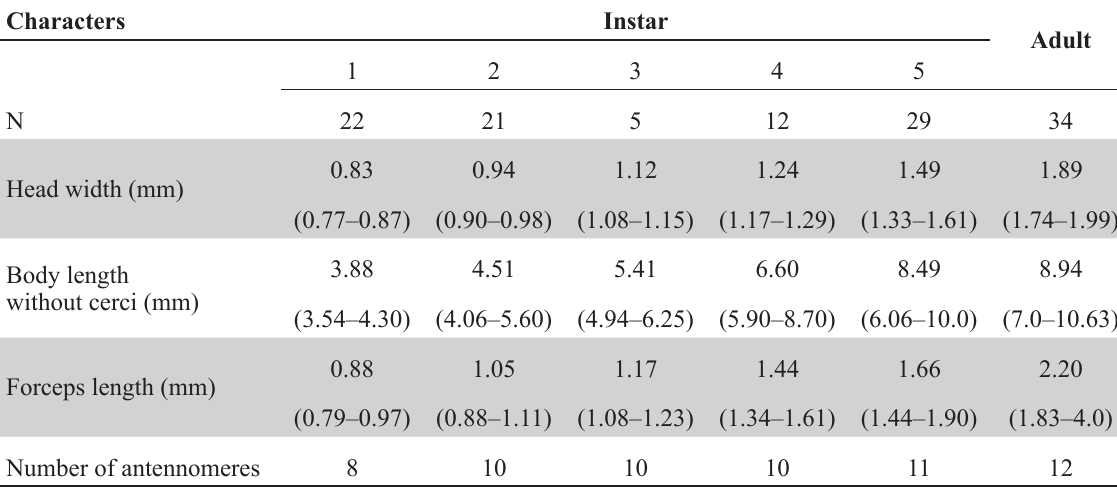
Table 4. Characterization of Pseudochelidura cantabrica Cuesta-Segura, Jurado-Angulo & García- París sp. nov. nymphal stages. Nymphs measured were obtained from Puerto de Vegarada, Puerto de La Farrapona, Puerto de Lunada and Puerto de las Estacas de Trueba. Average and minimum-maximum values are